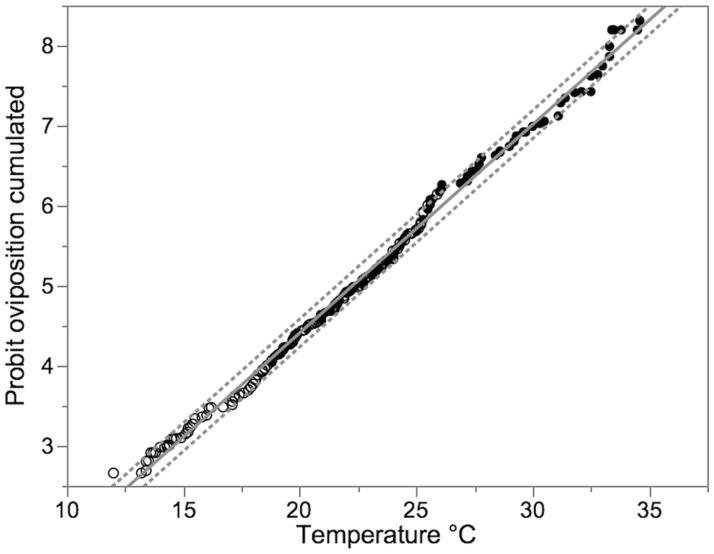
Linear correlation of cumulated proportion of eggs (transformed into probits) by corresponding fruit temperature.The grey line describes the equation: Probit oviposition cumulated = −0.79329 + 0.2602308 × temperaure °C; r² = 0.996; d.f. = 1, 200; F = 46650.75; p <0.0001; Probit standard error = 0.027; Temperature standard error = 0.001. The broken lines represent the 95% fiducial limits (r2 = 0.996, n = 202, p < 0.0001).